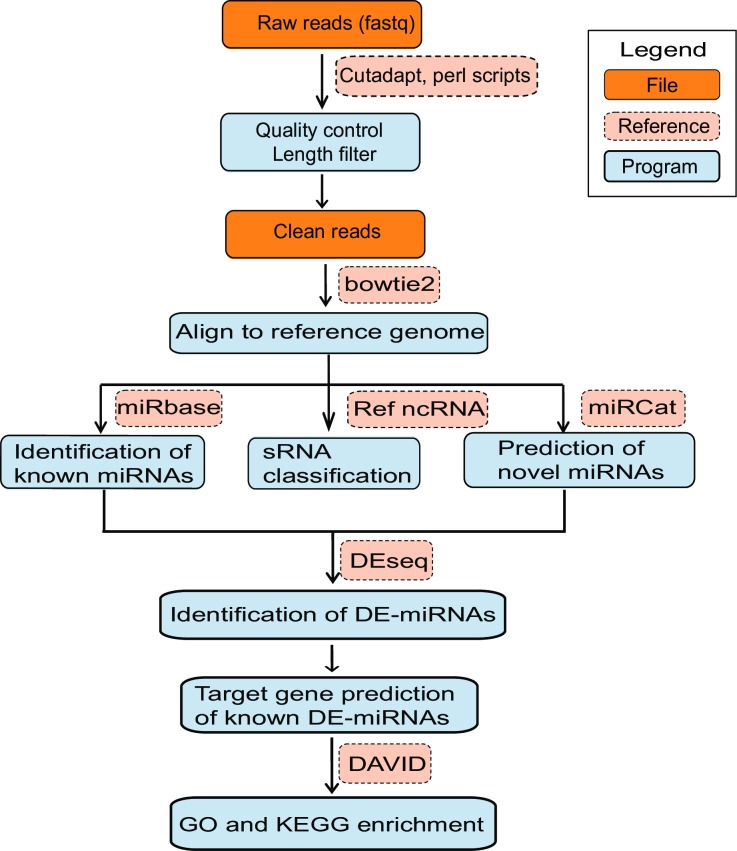
Pipeline workflow of small RNA search and target prediction.miRBase: microRNAs database, Ref ncRNA: reference non-coding RNA sequences, miRNAs: microRNAs, sRNAs: small RNAs, DE-miRNAs: differentially expressed miRNAs, DAVID: Database for Annotation, Visualization and Integrated Discovery, GO: Gene Ontology, KEGG: Kyoto Encyclopaedia of Genes and Genomes.